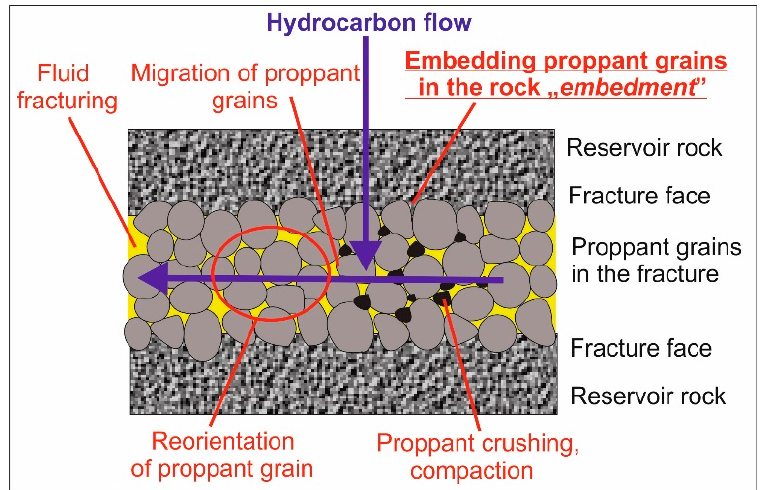
Figure 2. The phenomena influencing the effective packaging of a fracture and the achievement of high conductivity.